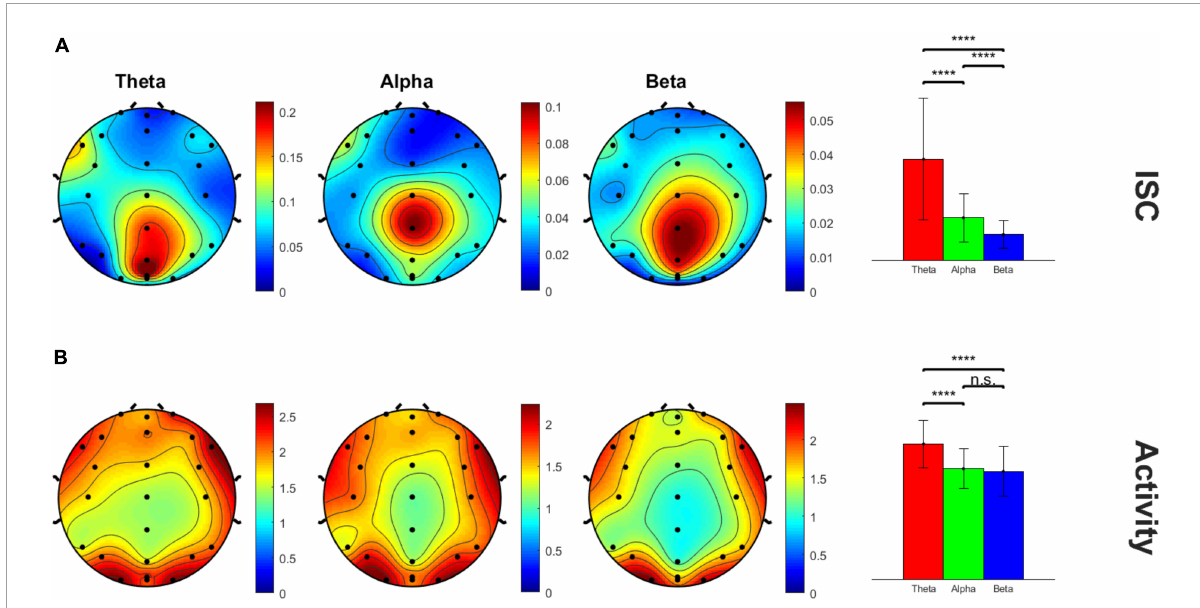
FIGURE2 Scalp topography maps of peak ISC window 8 across three frequency bands. (A) ISC values and (B) average neural activity on the scalp. The bar graph panel on the right plots the mean ± std peak time window ISC and neural activity values at midline centro-parietal electrodes across the three frequency bands. **** p < 0.001.